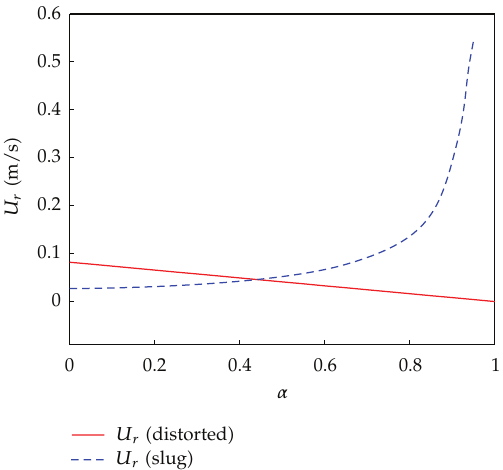
Figure 9: Relative velocity versus the total void fraction α for the distorted and slug drops.